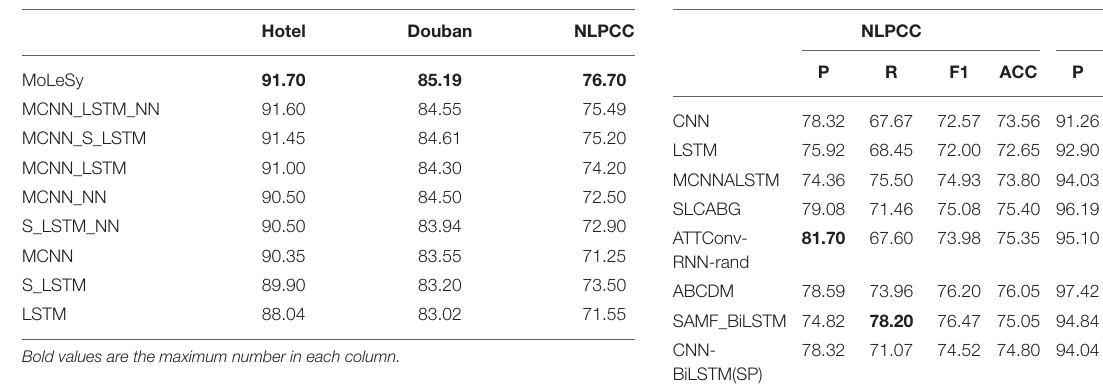
TABLE 5 | The accuracy of different models on the Hotel and Douban.